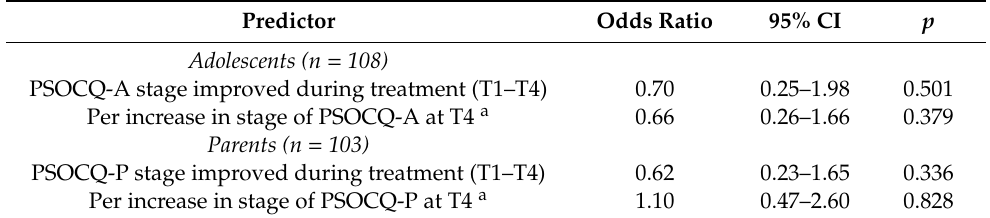
Table 3. Results of the univariate logistic regression analyses predicting non-response to treatment three months after